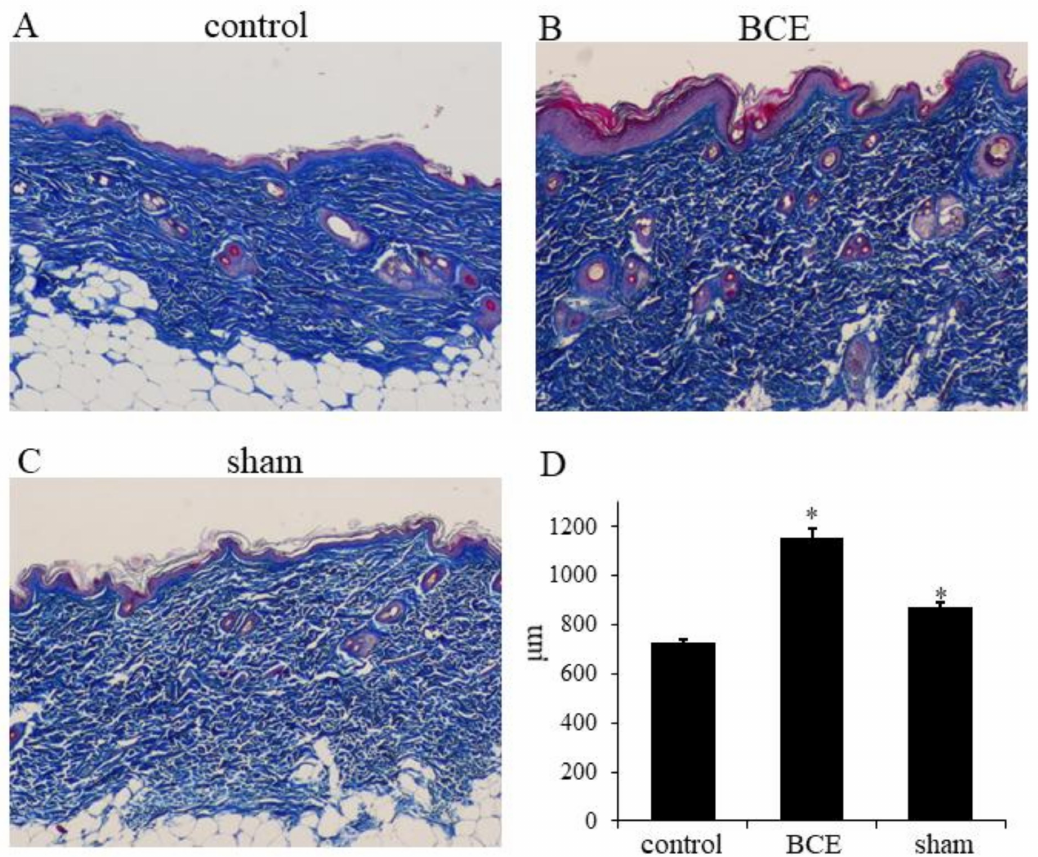
Figure 3. Light microscopy of Masson’s trichrome staining of skin in control (OVX + 0% BCE; ( A )), OVX + 3% BCE ( B ), and sham surgery rats ( C ). Images are at original magnification: × 40. ( D ) Quantification of the thickness ( µ m) of the collagen layer; * p < 0.05 vs. control (untreated OVX